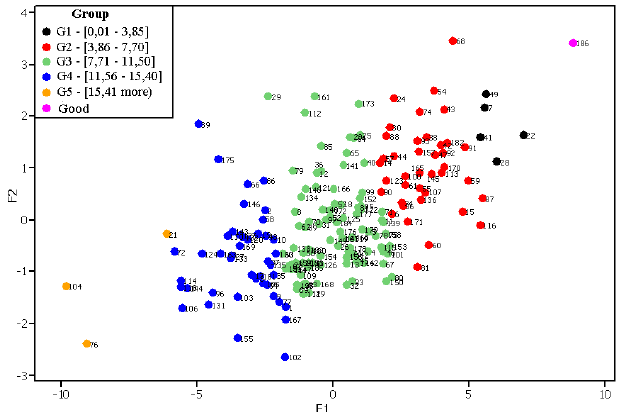
Figure 1. Dispersion graph according to the female